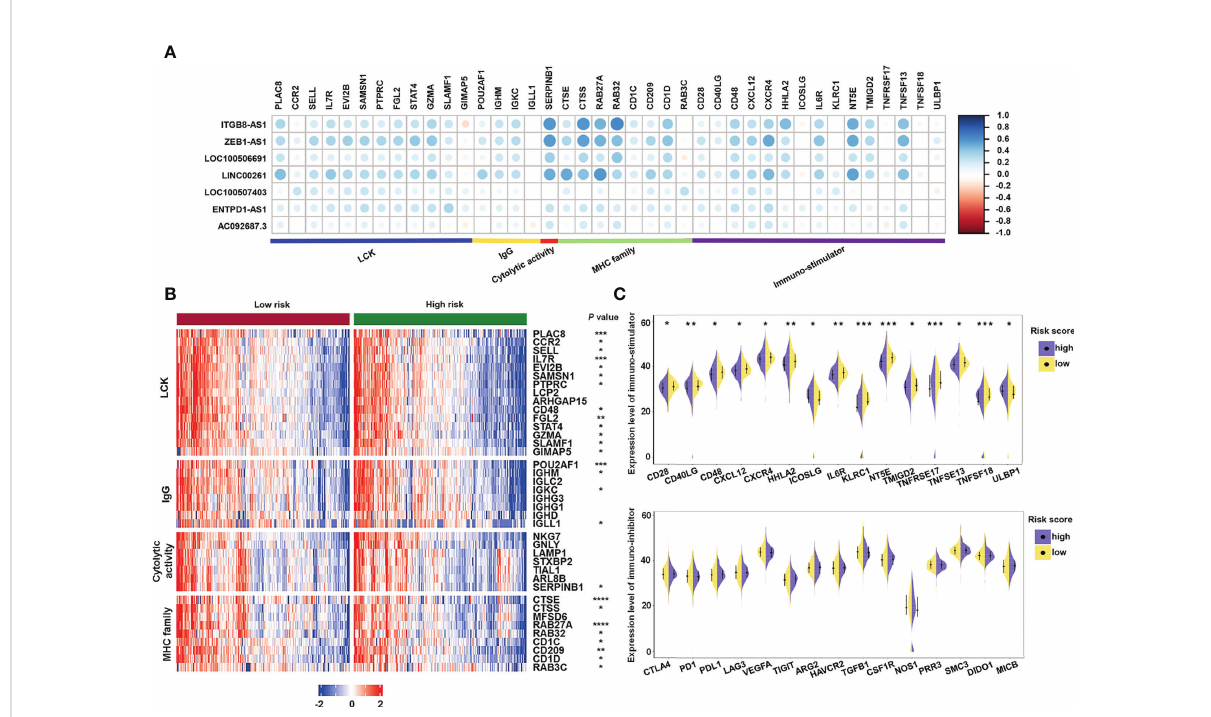
FIGURE 9 Analysis of the correlation between immune-related genes and sialylation-related lncRNA signature. (A) Heatmap of the correlation between expression of immune-related molecules and sialylation-related lncRNAs. (B) Expression of genes involved in the LCK pathway, IgG, cytolytic activity, and the MHC family in different risk groups. (C) Analysis of immune-stimulator and immune-inhibitor expression with different risk scores. LCK , lymphocyte-speci fi c protein tyrosine kinase; IgG, immunoglobulin G; and MHC, major histocompatibility complex. **** P < 0.0001; *** P < 0.001; ** P < 0.01; * P <